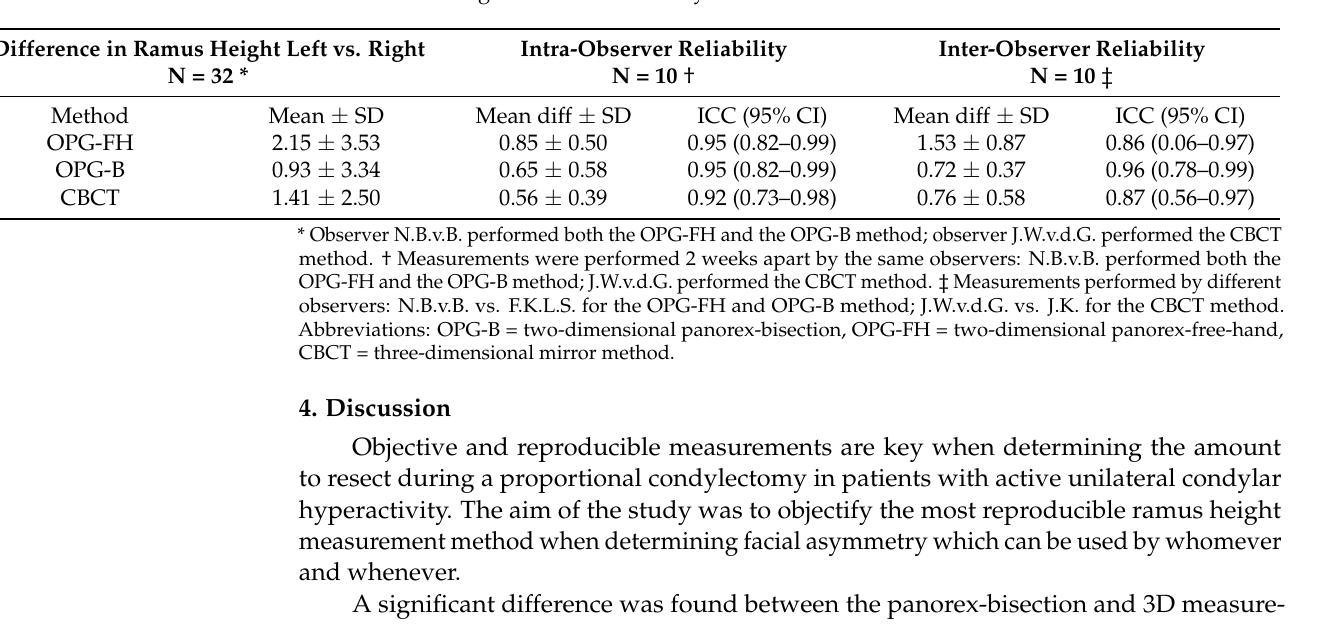
Table 1. Measuring results and reliability